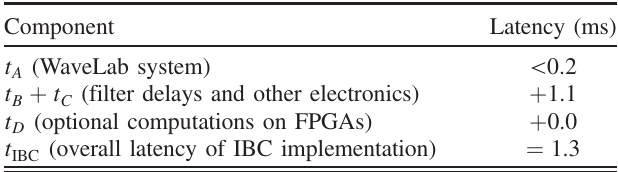
TABLE II. Latencies of the 1D IBC implementation.